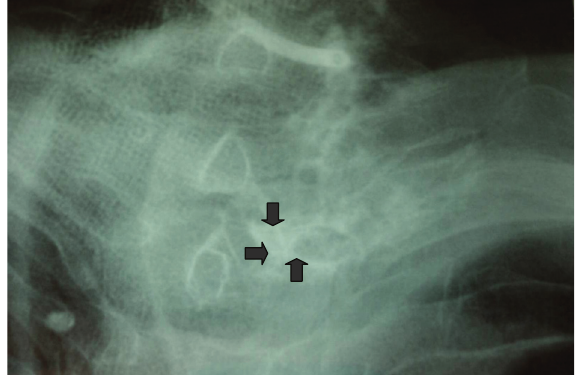
Figure 2: Fistulography showing contrast material passing to thyroid gland and confined to the left lobe (three arrows).